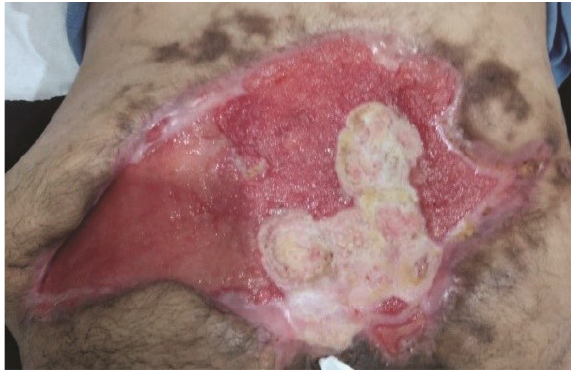
Figure 3. Tumor Recurrence Two Months After Mass Removal.